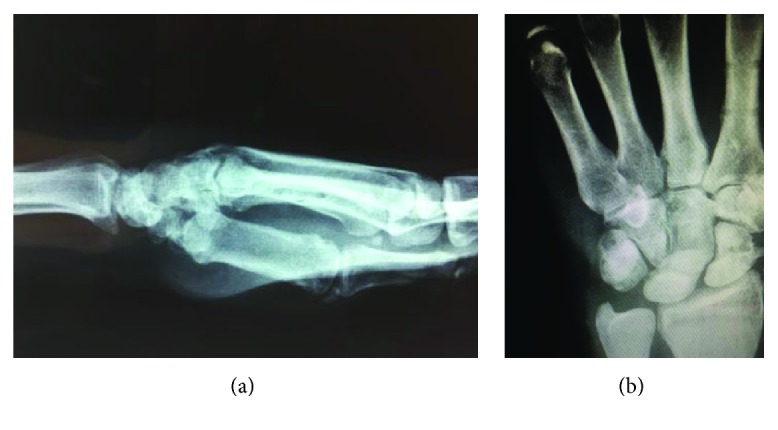
X-ray at one year.